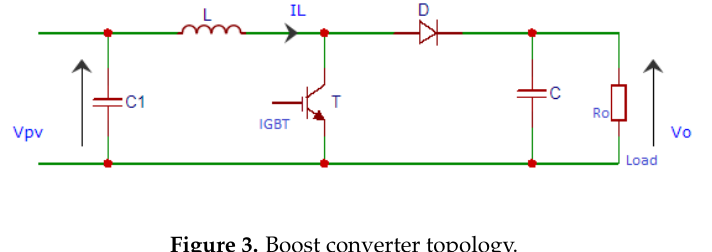
Figure 3. Boost converter